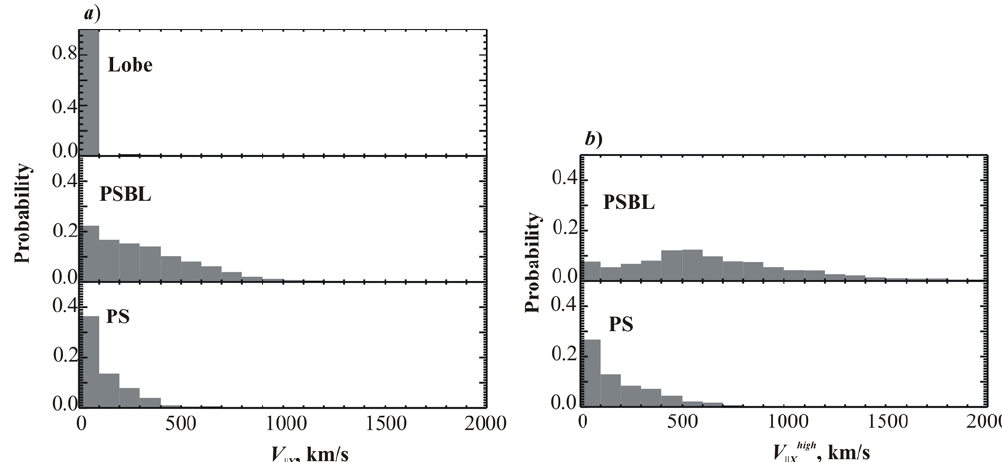
Fig. 8. A histogram of the distribution of the observation probability of the absolute value of the X-component of the ion parallel velocity calculated for the entire energy range, V || X in the lobe, the PSBL and the outer PS region (a) , and a histogram of the probability distribution of the V high || calculated for the high-energy part of the spectrum ( > 2keV) in the PSBL and the outer PS region (b) . X